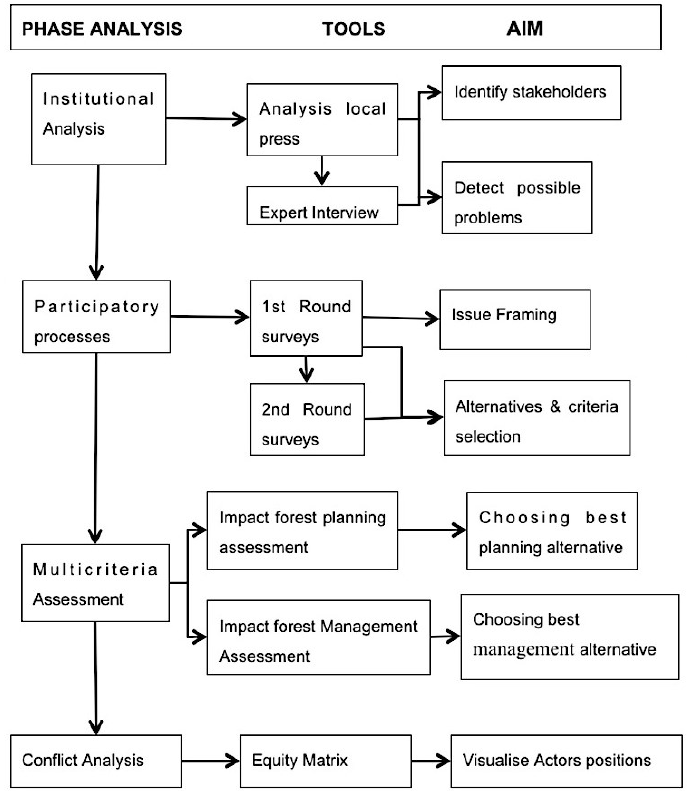
Figure 1. Integrated assessment methodology for forest